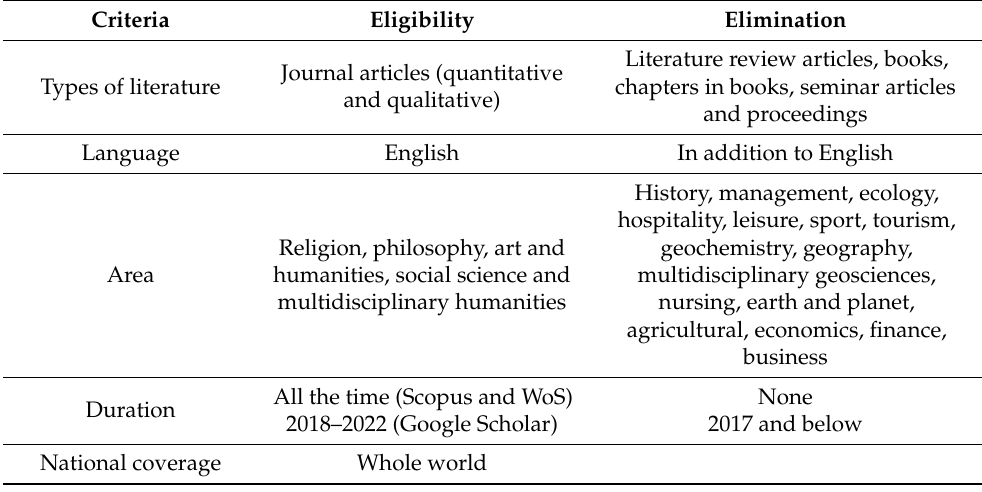
Table 2. Eligibility and elimination criteria.